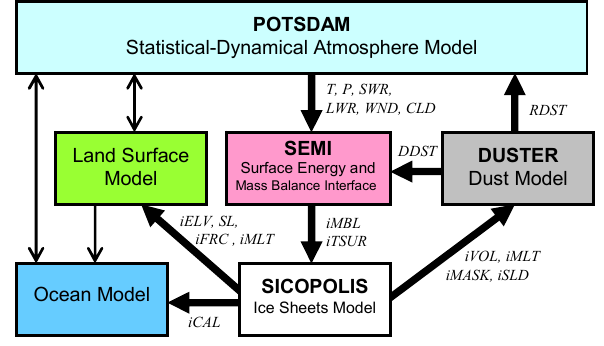
Table 1. Abbreviations of information fluxes shown in Fig.